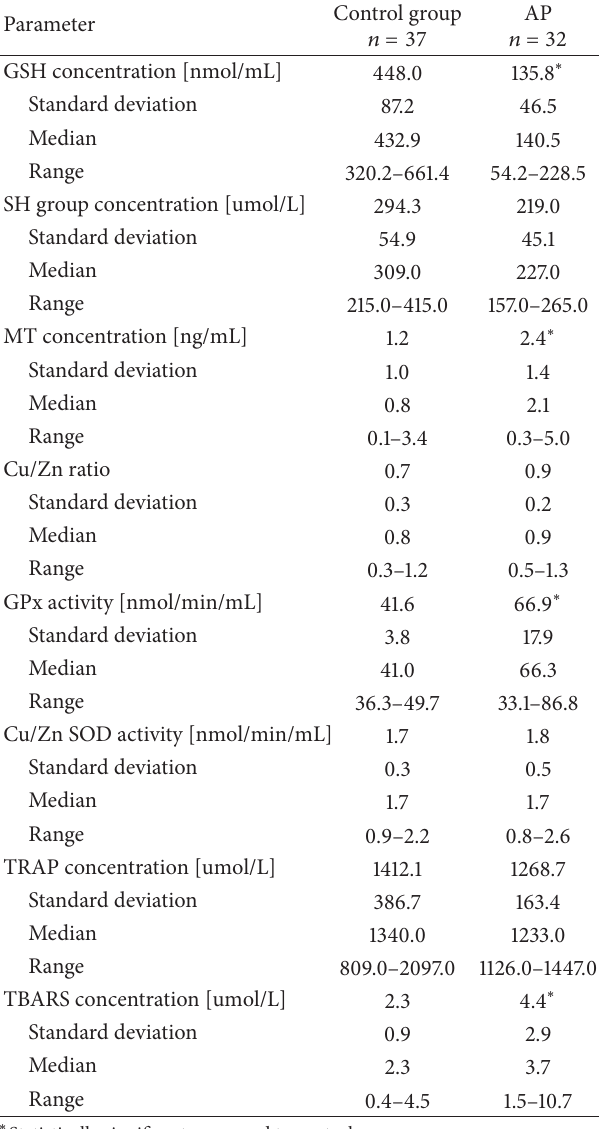
Table 2: The parameters of pro/antioxidant balance in patients with acute pancreatitis compared to control group.